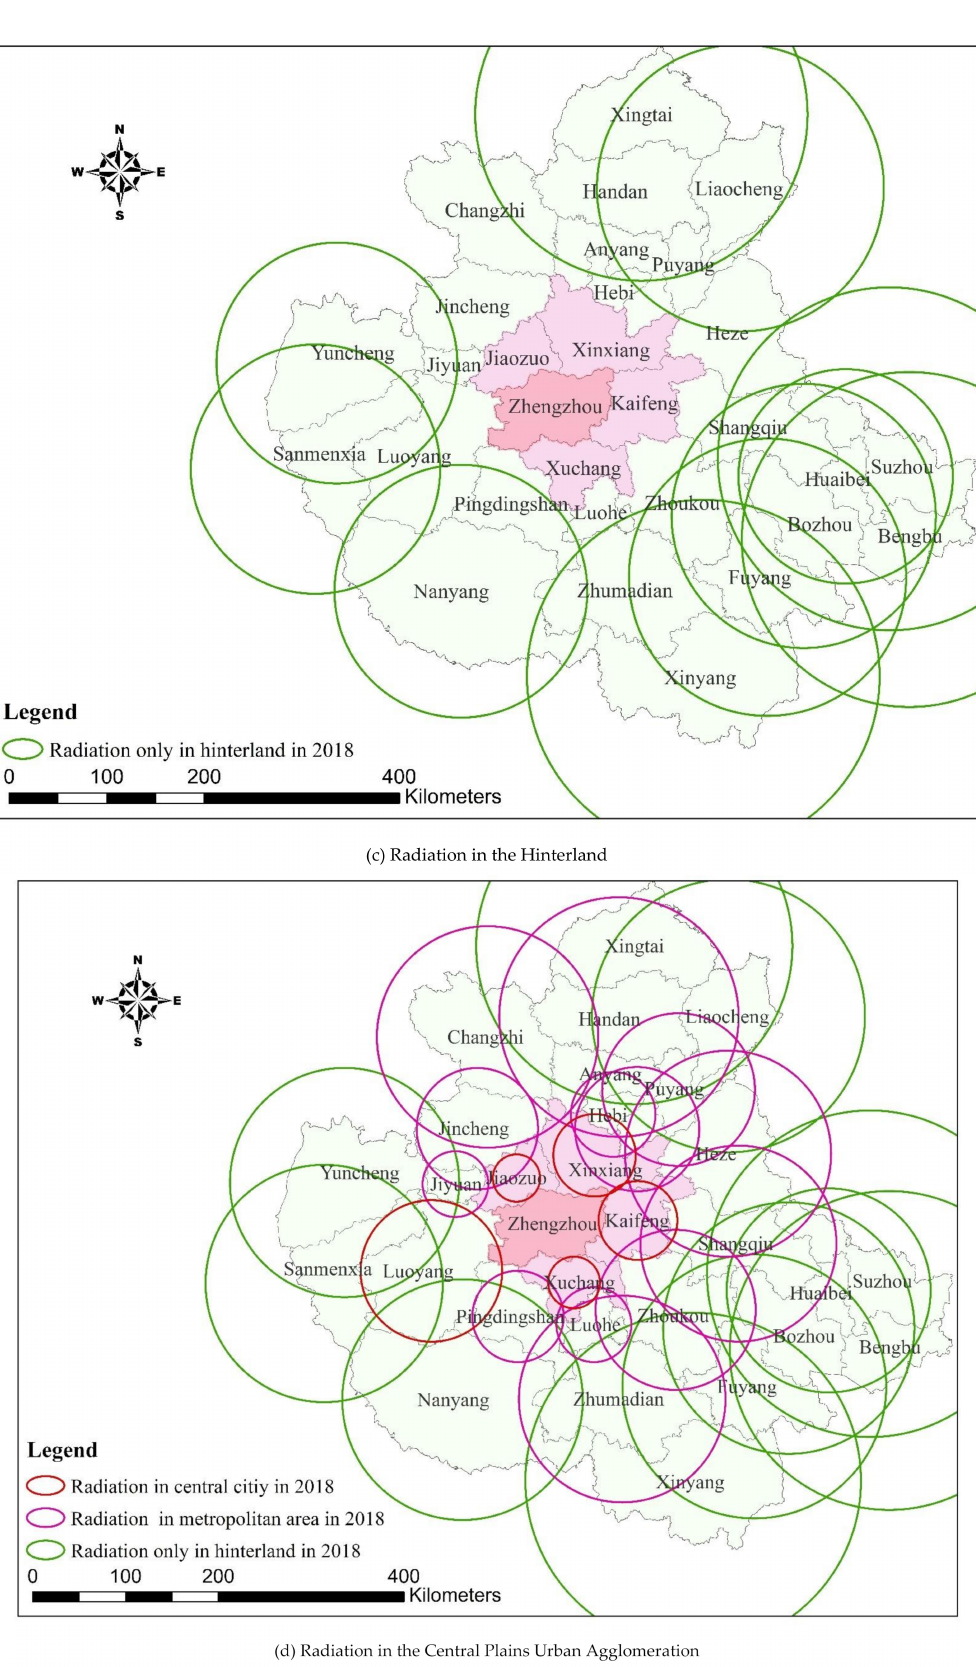
Figure 6. The ESV spatial radiation range of cities in the Central Plains Urban Agglomeration in